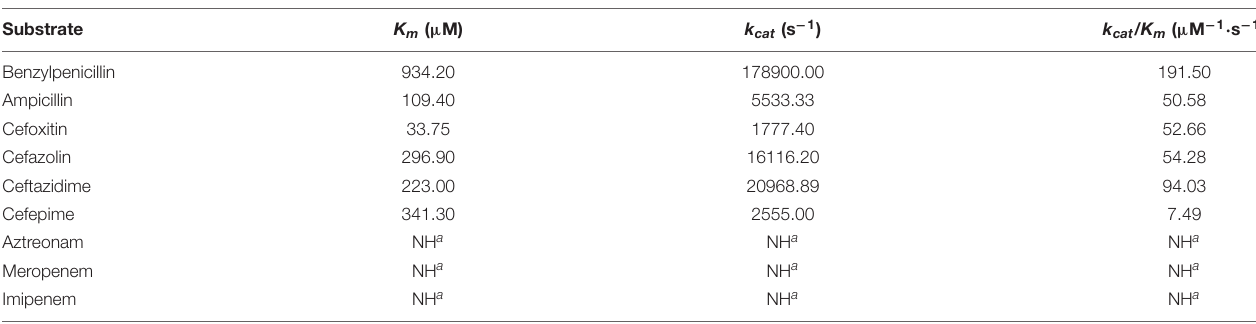
FIGURE 2 | A phylogenetic tree showing the relationship of YOC-1 with other chromosome-borne AmpC β -lactamases. YOC-1 from our study is shown with a red dot. TABLE 5 | Kinetic parameters of β -lactam antibiotics for the β -lactamase